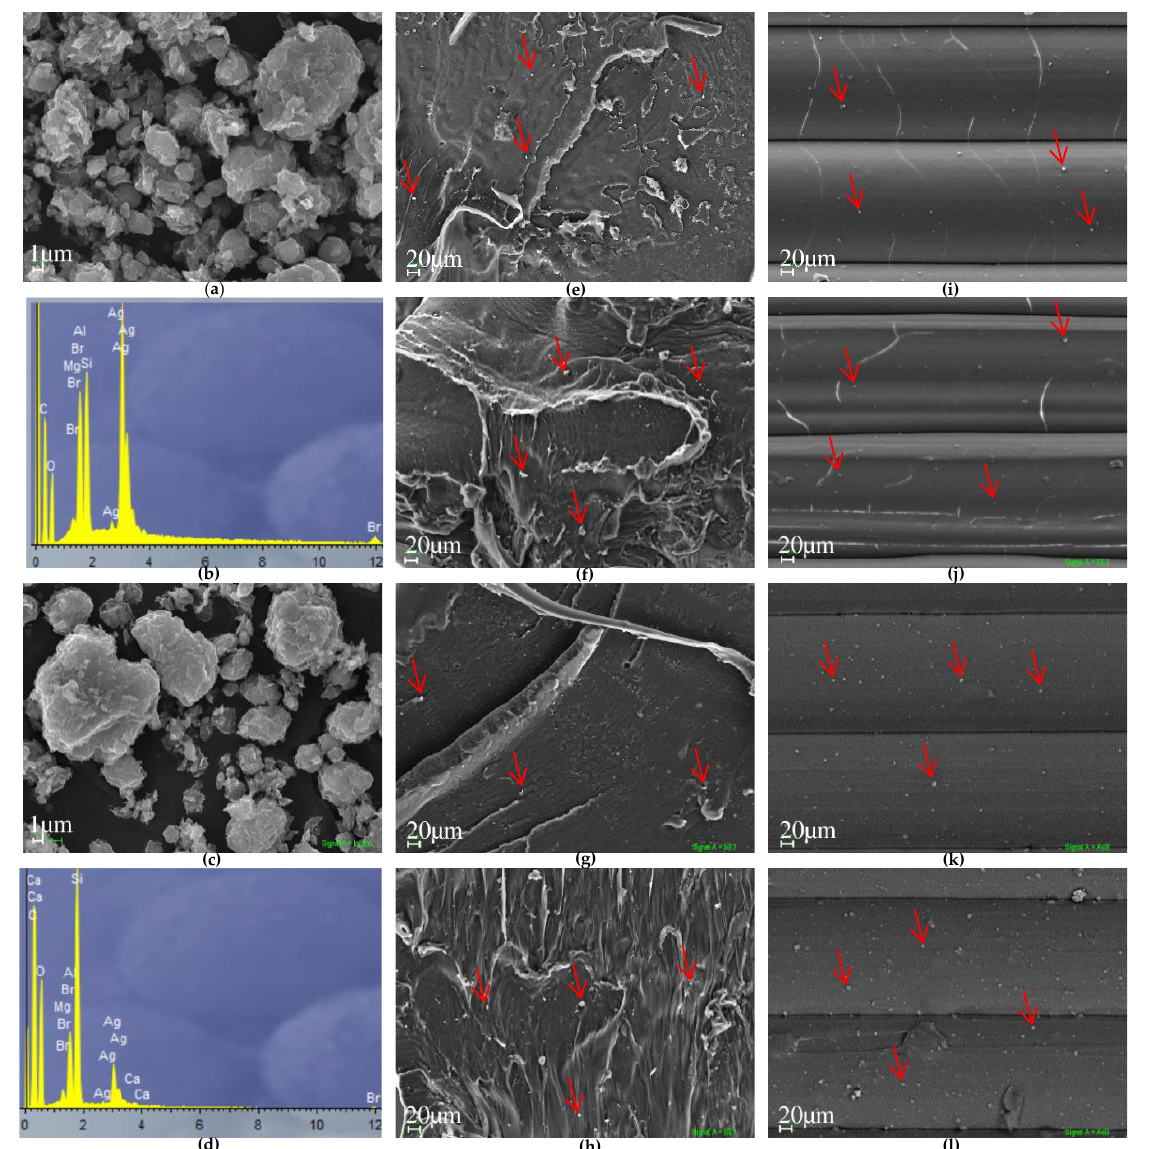
Figure 3. Scanning Electron Microscopy, SEM ( a ) Morphology additive R148 ( b ) EDX R148 ( c ) Mor- phology additive S254 ( d ) EDX S254 ( e ) Particle distribution PLA/R1 in pellets ( f ) Particle distribu-